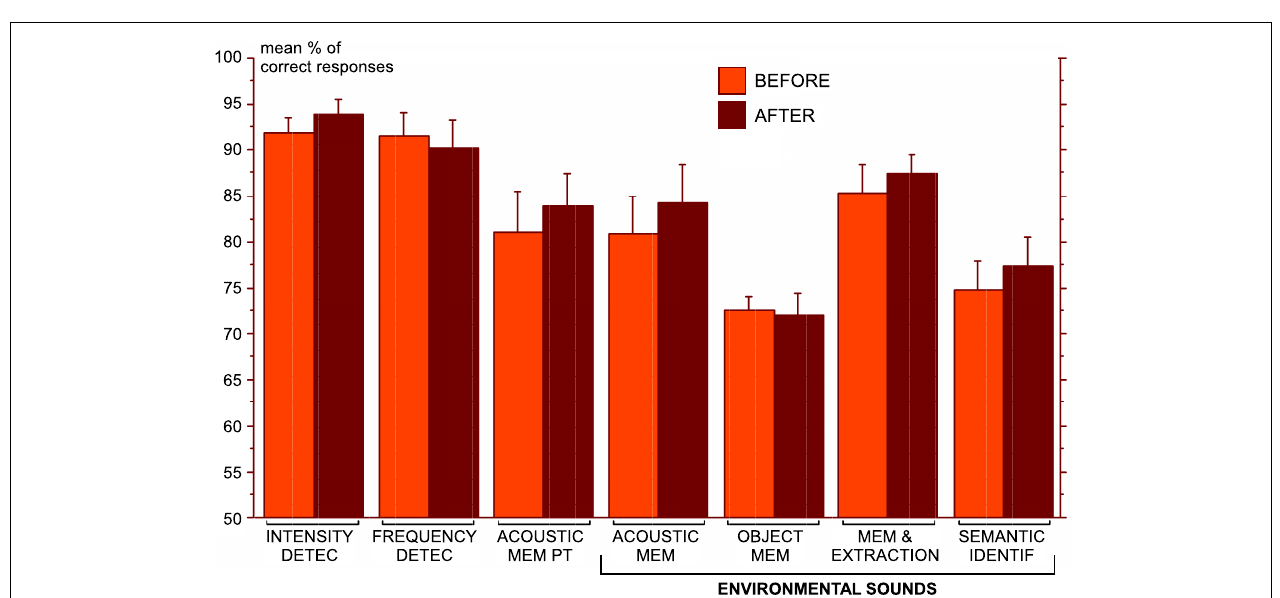
FIGURE 3 | Mean percentage of correct responses and standard error obtained before (in orange) and after (in brown) surgery in the PRE-POST group ( n = 8), for each auditory test. No signifi cant difference (Wilcoxon tests)